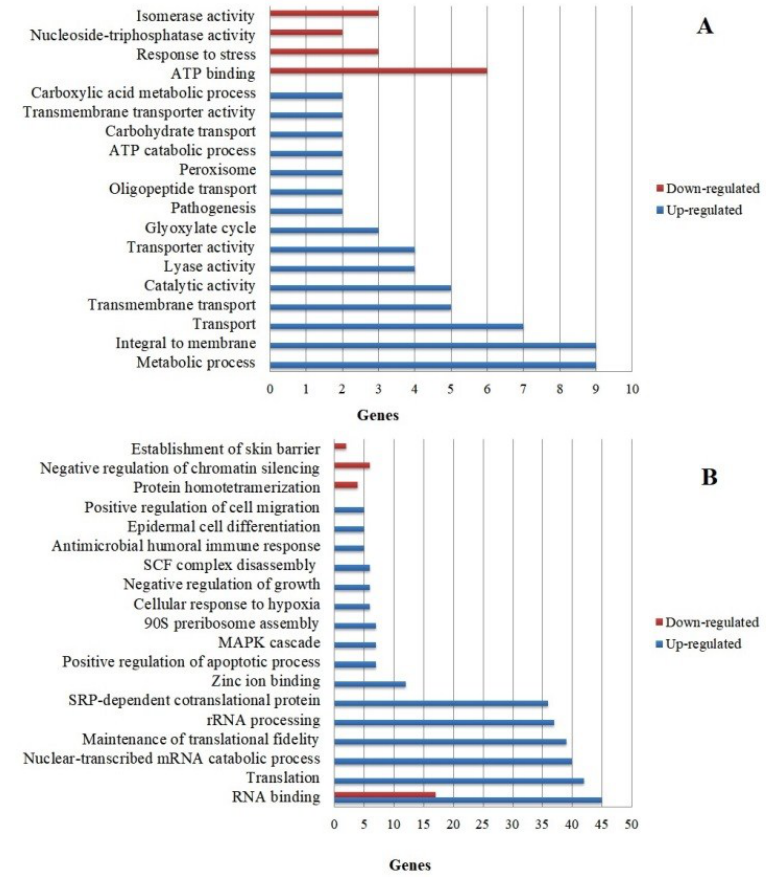
Figure 2. The gene Ontology-based functional categorization of differentially expressed genes. The main representative functional categories ( p < 0.05) of genes differentially expressed in T. rubrum ( A ) and HaCat ( B ). Table 3. Some functional categories and related genes important for the pathogenesis of T. rubrum.